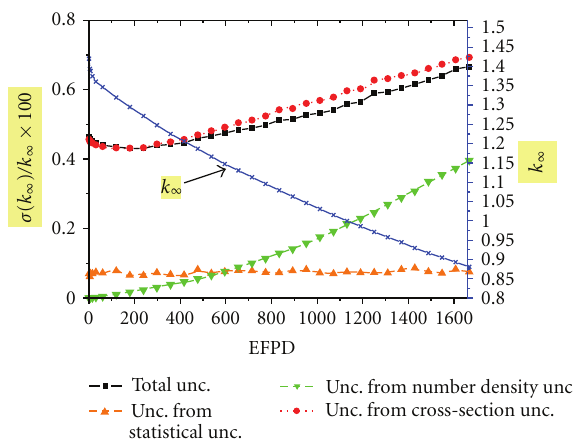
Figure 3: k inf and σ [ k inf ] versus pin burnup with SCALE6.1/COVA- 43G covariance